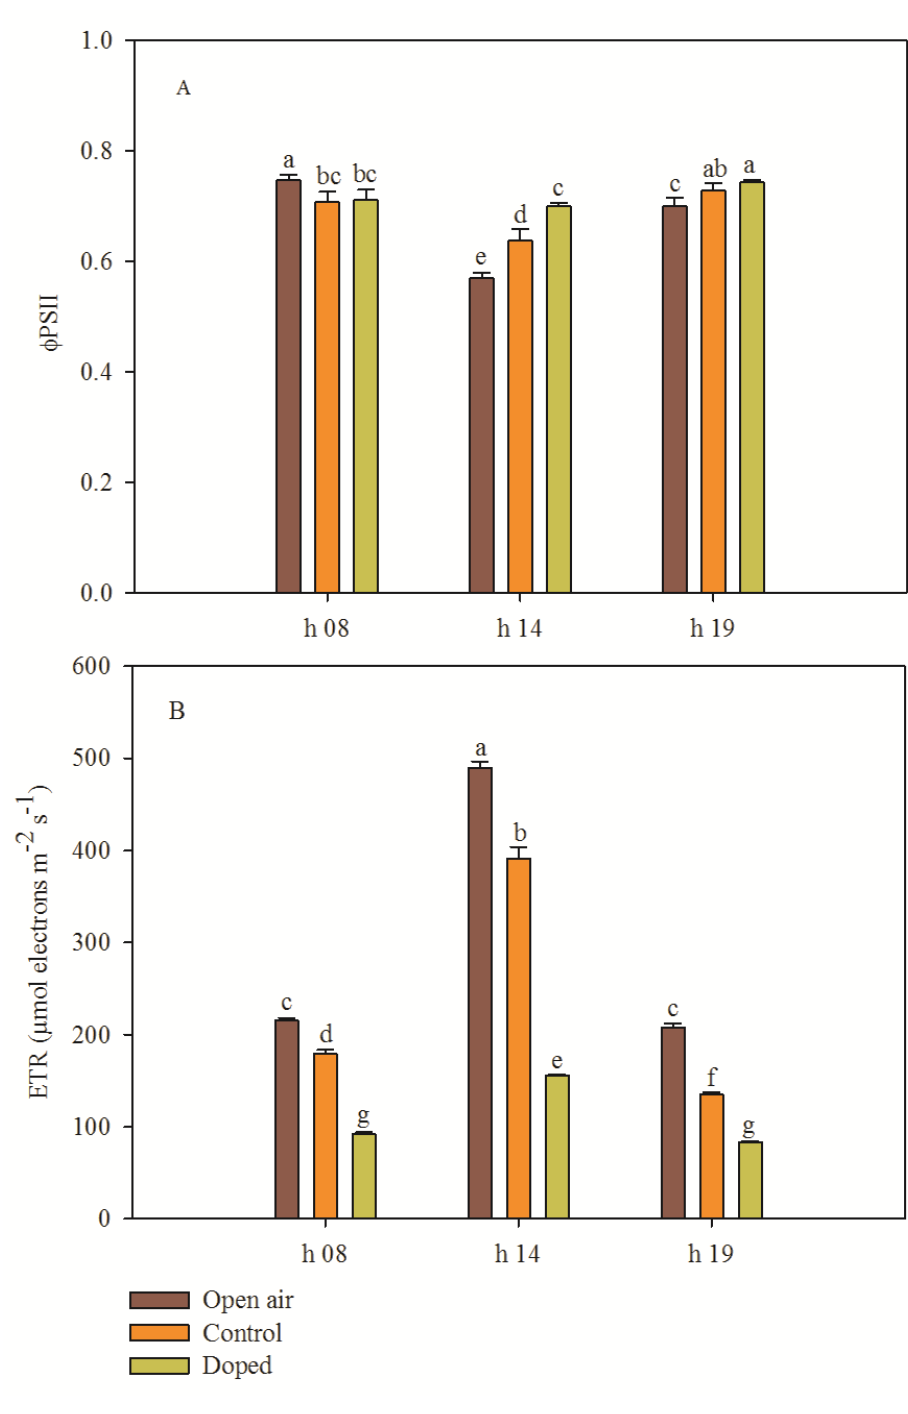
Figure 5. Effective quantum yield ( Φ PSII) ( A ) and photosynthetic electron transport rate (ETR) ( B ) as affected by greenhouse cover material. Vertical bars indicate mean ± standard error. Different letters indicate significant differences according to Tukey’s HSD test ( p ≤ 0.05). Φ PSII is a dimensionless ratio (no units); h = hour of the day.